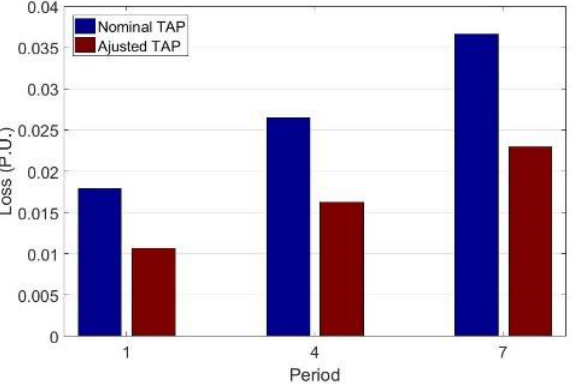
Figure 16. IEEE 123-bus system, electrical losses, 0% PV, with adjusted taps and nominal taps.